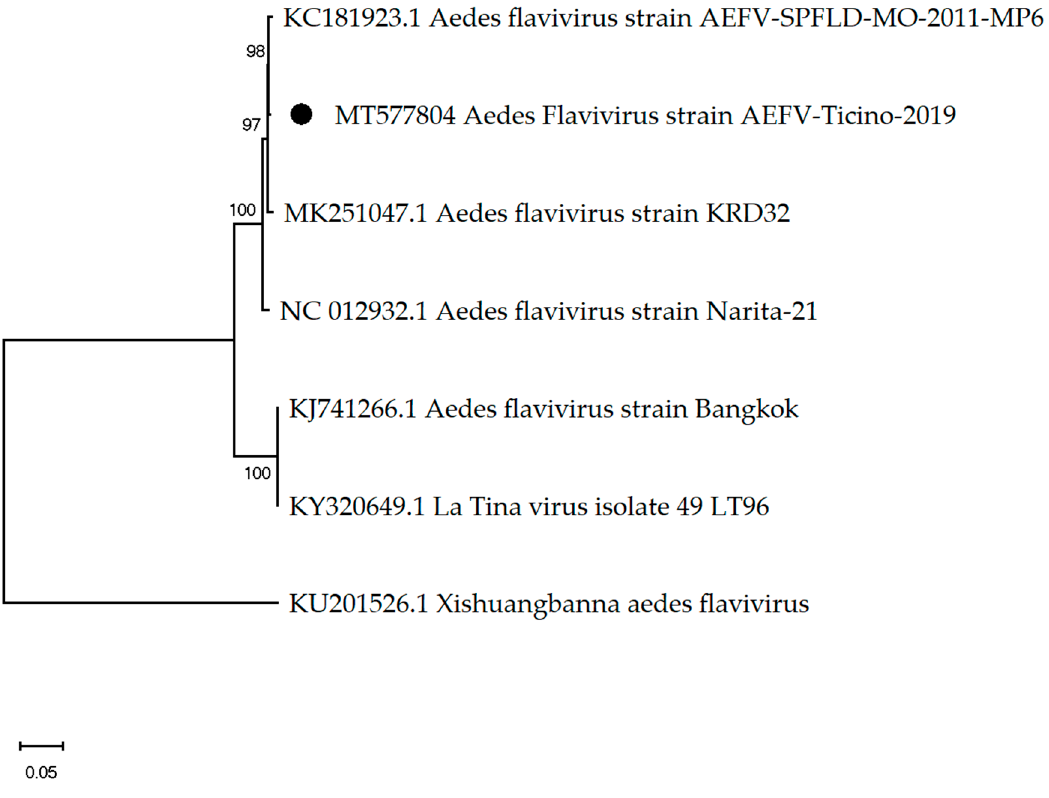
Figure 2. The phylogenetic tree of Aedes flaviviruses constructed using the maximum likelihood method and Kimura 2-parameter model. The percentage of replicate trees in which the associated taxa clustered together in the bootstrap test (1000 replicates) are shown next to the branches. The black dot indicates the genome sequenced in this study.